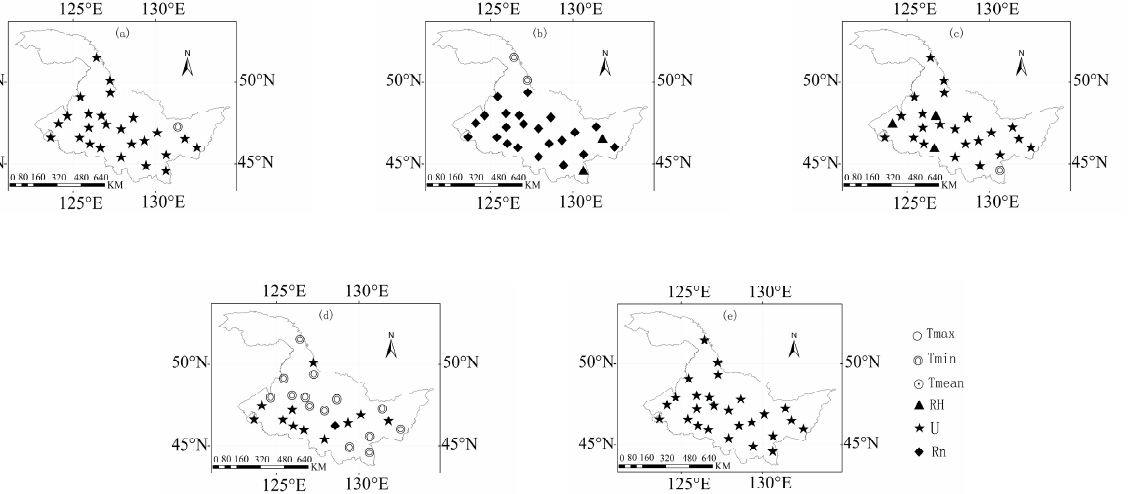
Figure 7. Spatial distribution of dominant climatic factors in ( a ) spring, ( b ) summer, ( c ) autumn, ( d ) winter and ( e ) inter-annually in the study area from 1960 to 2019.